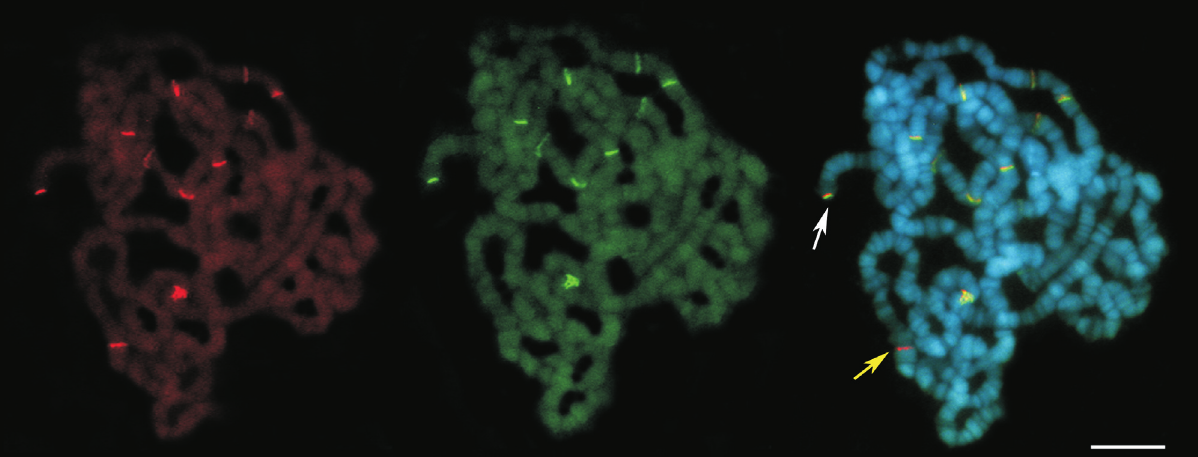
Figure 3 - FISH on polytene chromosome of D. simulans (locality GO01) using two P -element probes: exon 1-red (left panel), exon 2-green (middle panel),andexon1+2(rightpanel).ThechromosomewascounterstainedwithDAPI-blue.Botharrowspointtoterminalregionsinsertions.Thewhitear- rowindicatesco-hybridizationofexon1andexon2probes.Theyellowarrowshowsasingleprobehybridization(exon1).Scalebarrepresents10 (cid:3)